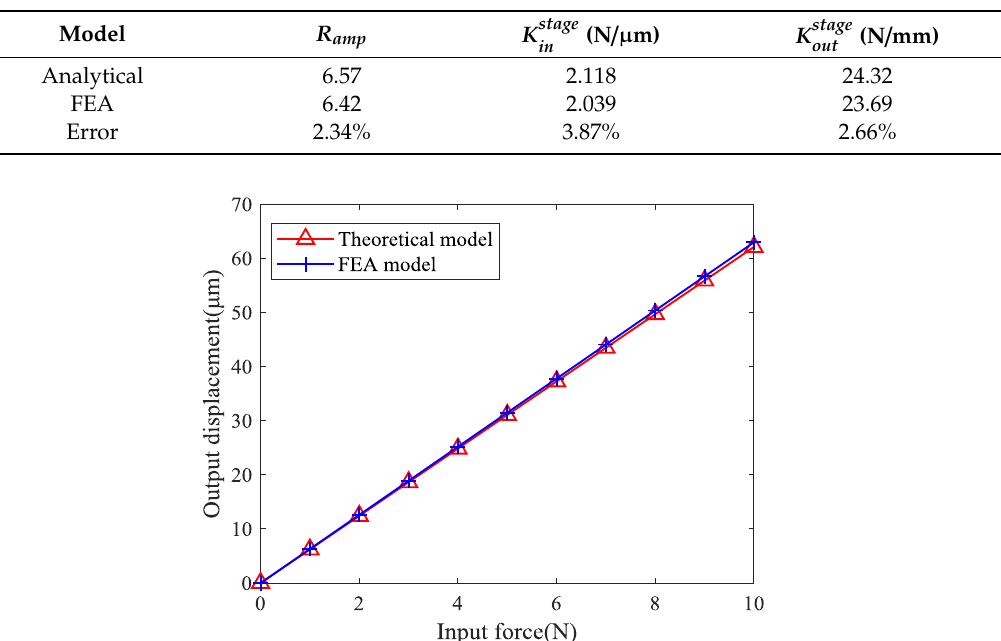
Figure 14. Analysis of the maximum stress by ANSYS.